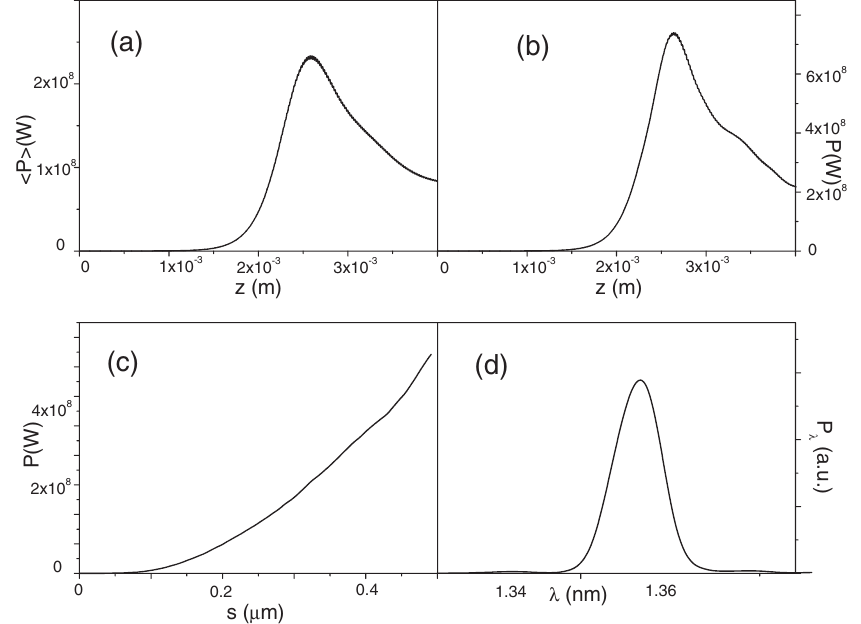
FIG. 7. (a) average power P (W) vs the coordinate along the undulator z (m); (b) peak power along z ; (c) power profile along the bunch coordinate s ( (cid:4) m ) at z (cid:6) 2 : 5 mm ; (d) power spectrum at z (cid:6) 2 : 5 mm